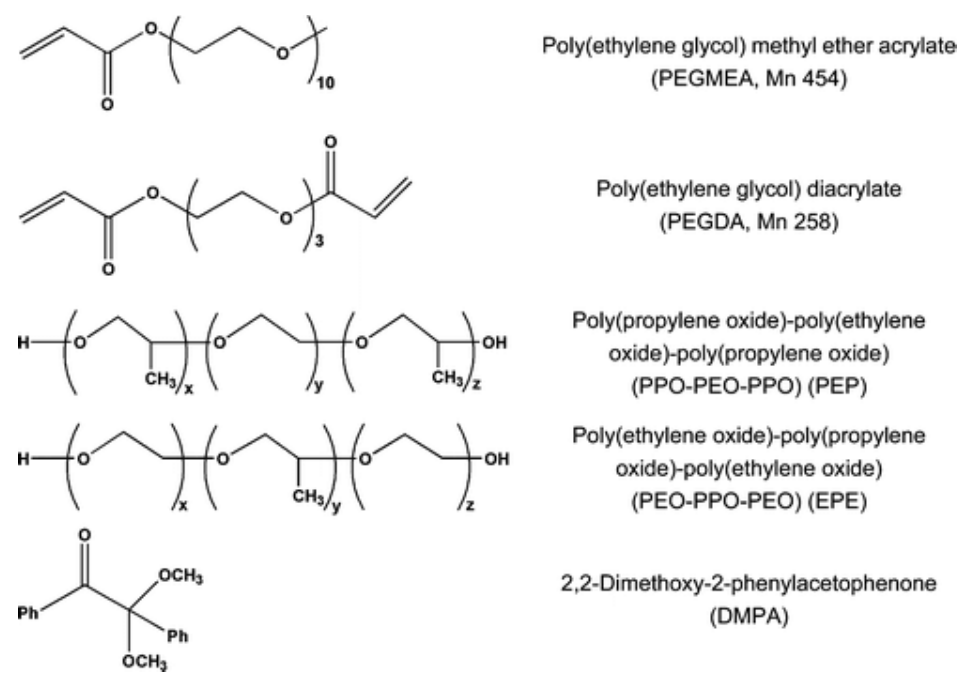
Figure 8. Structural formulas of reagents for synthesizing the monoliths [128]. Reprinted with permission from the American Chemical